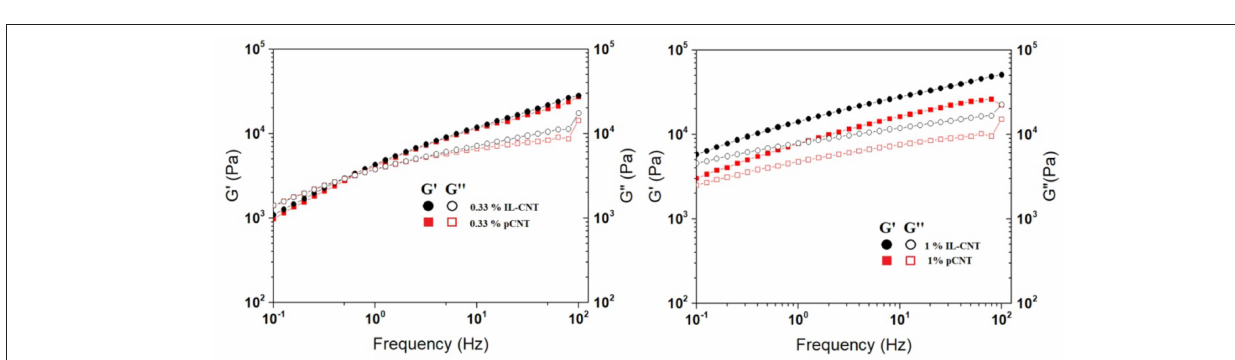
FIGURE 3 | Storage modulus vs. frequency for the PS/PBAT composites as a function of the filler content.